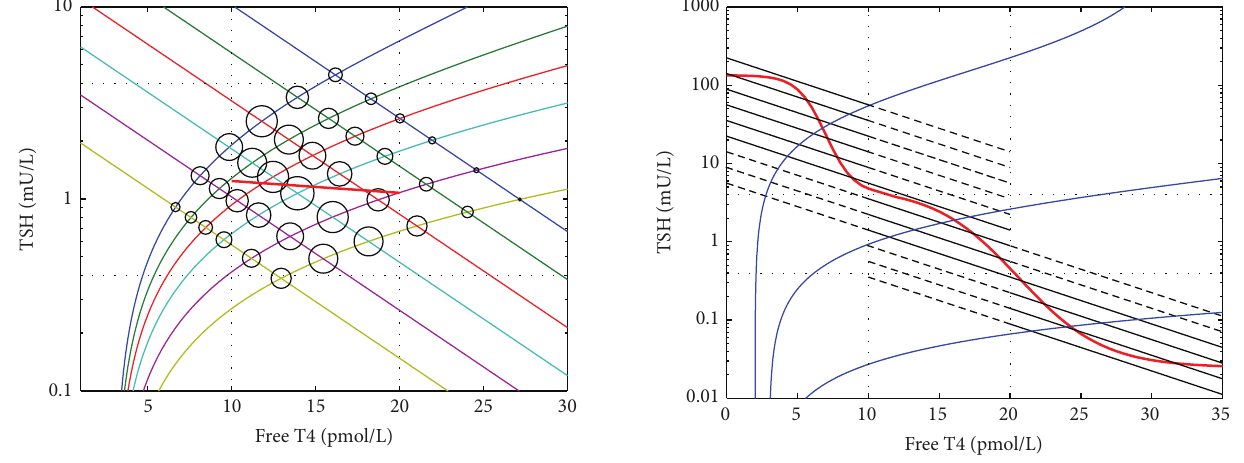
Figure 6: The effect of vertical shifts in the TSH curves, induced by primary thyroid dysfunction, on the points of intersection of the physiological curves. On account of these changes the T4 curves in the hypothyroid and hyperthyroid ranges do not intersect with the extensions of the TSH curves of the normal range (these extensions are shown as dashed lines) and therefore the slope of the population curve increases. The extensions of the TSH curves into the normal range from the regions of thyroid dysfunction are also shown as dashed lines to indicate that they do not normally exist in this range. The red line is the population curve as per Hadlow et al.